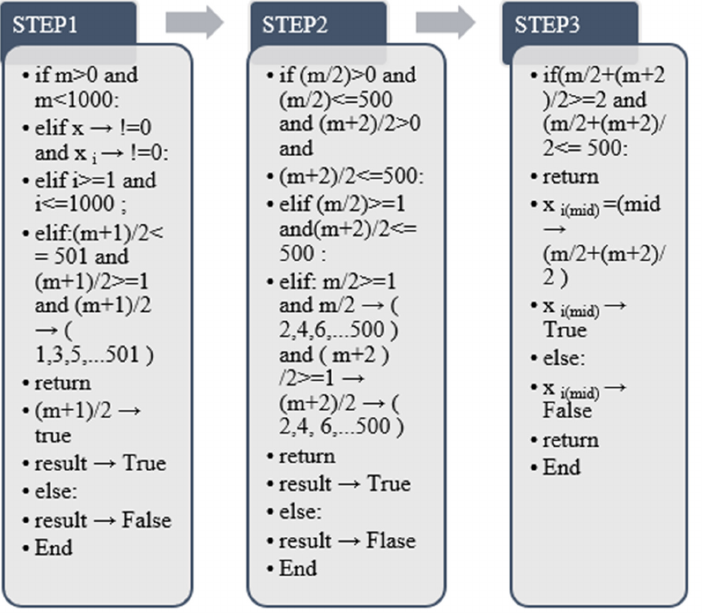
Figure 5. HAPT data collection process model diagram.